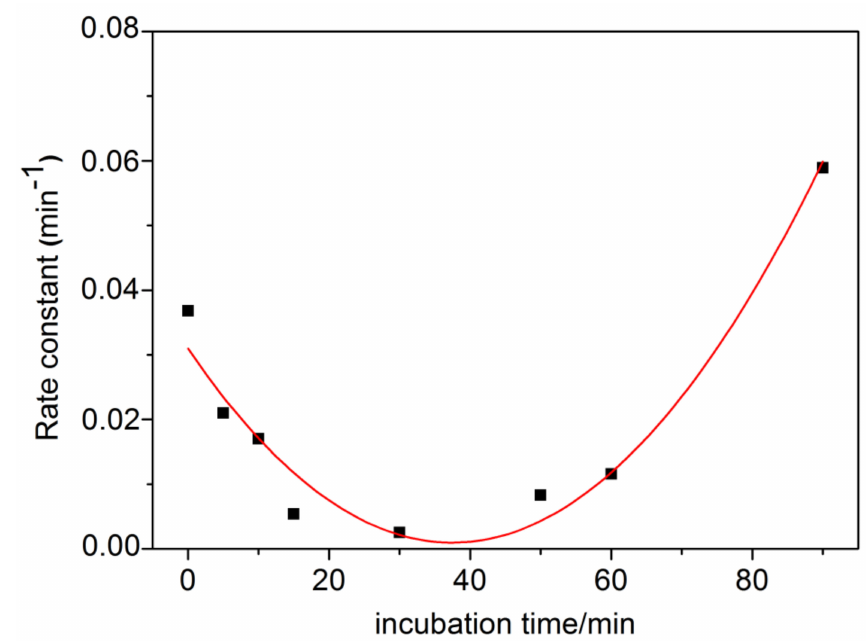
Figure 14. Observed phosphorylation rate constant of hAChE by 50 nM paraoxon as a function of enzyme pre-incubation time (from 0 to 90 min) in the presence of 10 nM